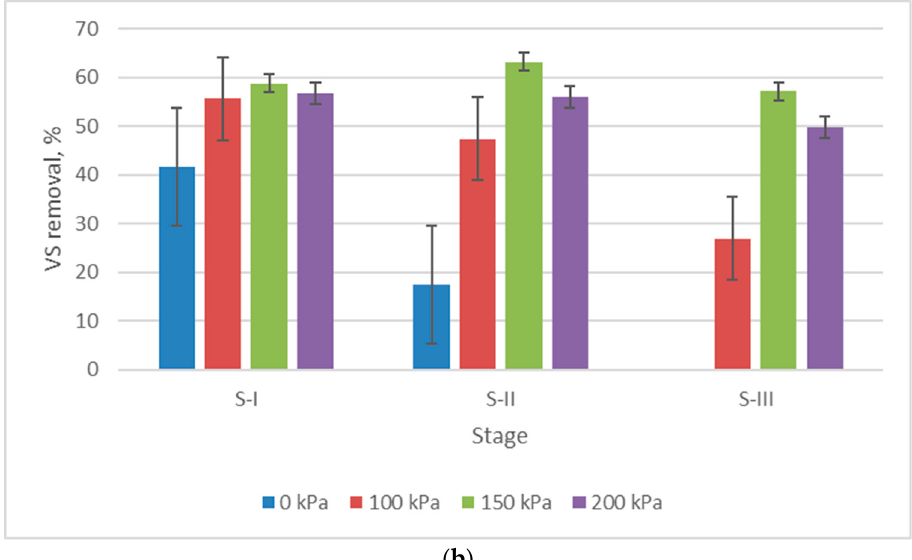
Figure 7. Dynamics of pH values ( a ) and average vs. removal ( b ) depending on the overpressure and HRT in the digesters.